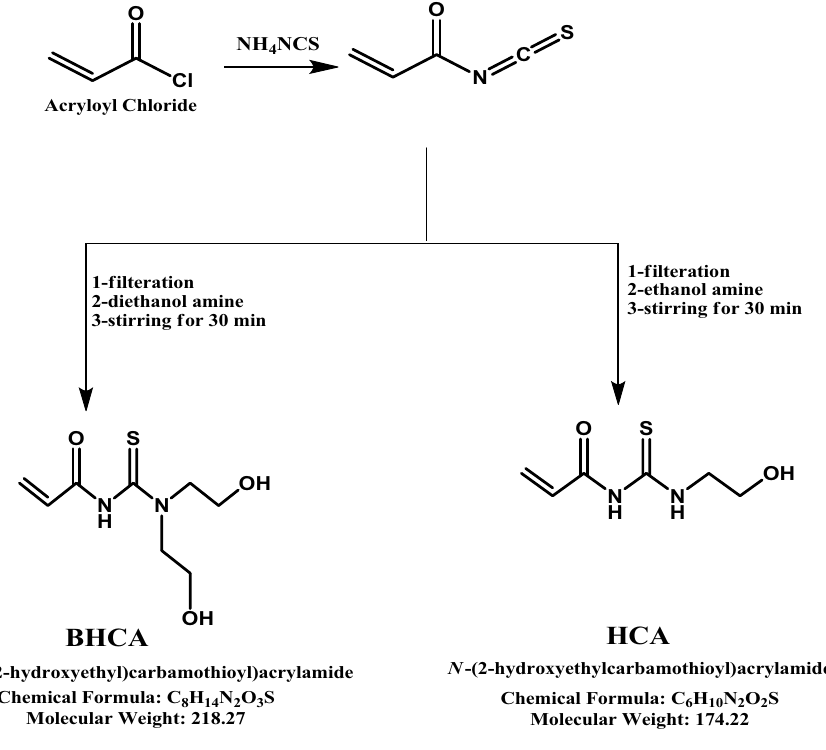
Figure 1. Chemical structure of the synthesized HCA and BHCA derivatives.